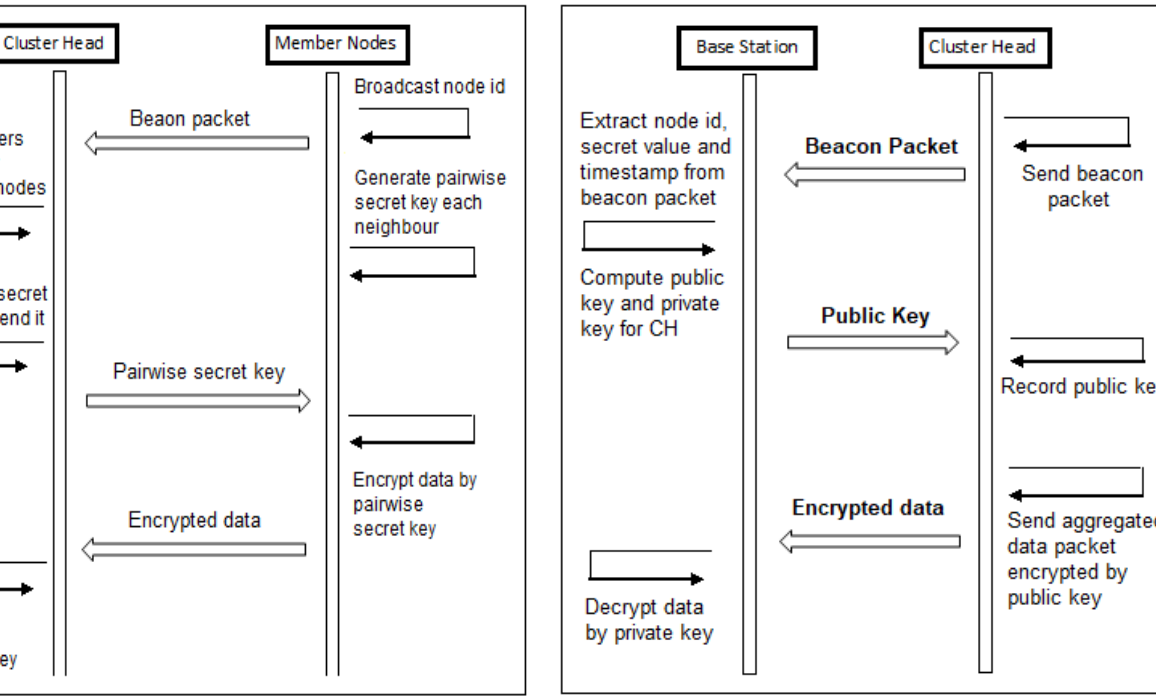
Figure 2. Sequence diagram of secure communication between the CH and its member nodes